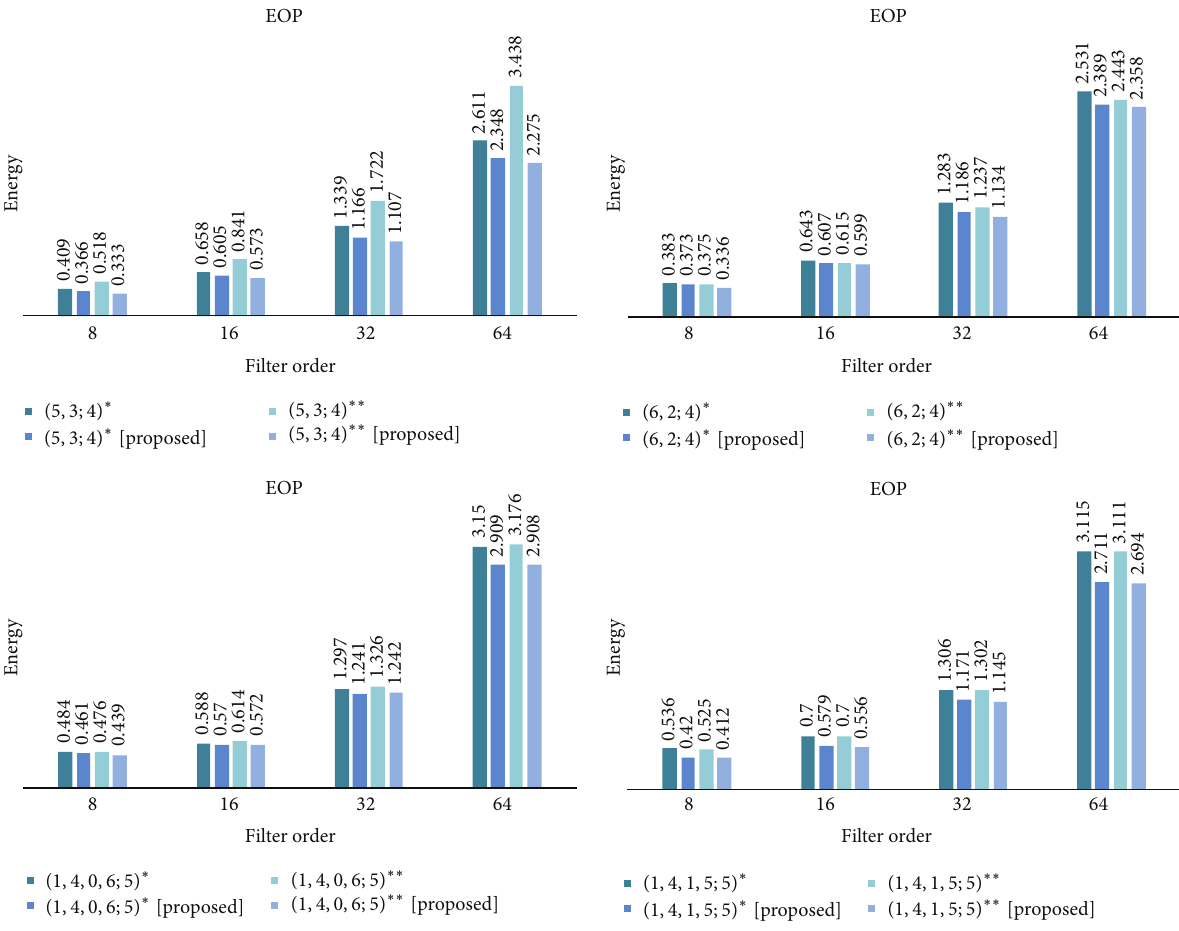
Figure 17: Energy per operation (in nJ) for filters based on different GPCs on Kintex-7